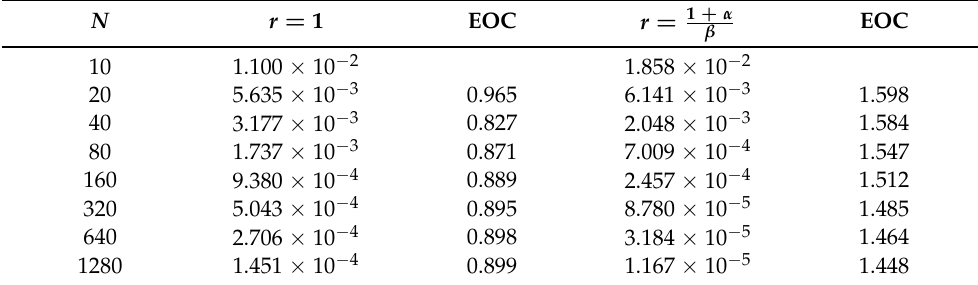
Table 2. Table showing the maximum absolute error and EOC for solving (25) using the predictor- corrector method for α = 0.4, β = 0.9.